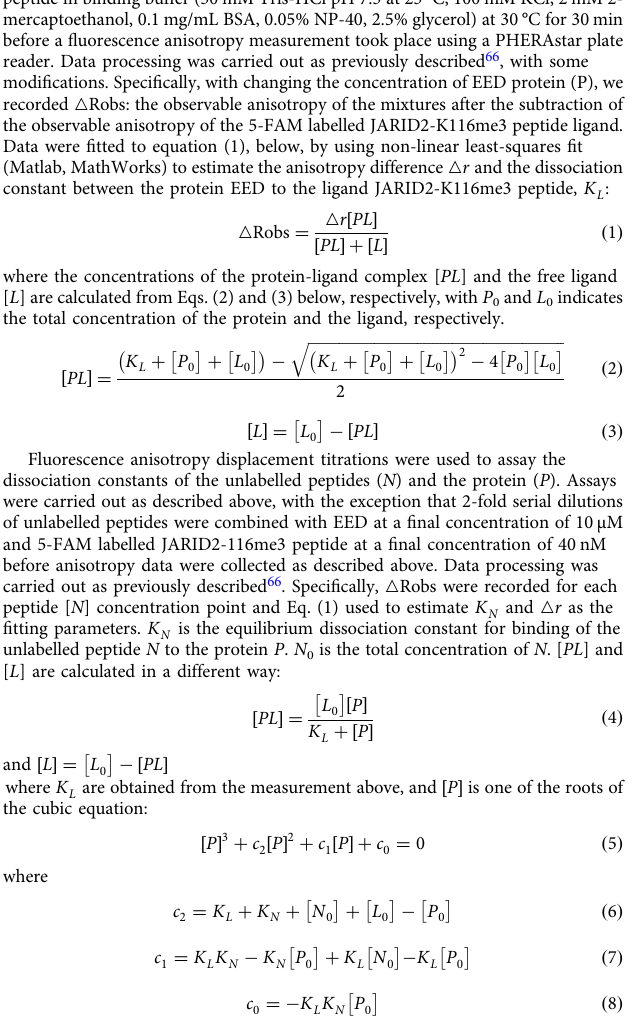
Electrophoretic mobility shift assay . Cy5-DNA or Cy5-H2A labelled nucleo- somes were diluted using binding buffer (50 mM Tris-HCl, pH7.5 at 25°C, 100 mM KCl, 2mM 2-mercaptoethanol, 0.05% v/v NP-40, 0.1 mg/mL BSA, 5% gly- cerol, with additional 5ng/µL Salmon Sperm DNA for measuring binding for Cy5- H2A labelled nucleosomes). In total, 2-fold serial dilutions of protein in binding buffer were combined with nucleosome probes, to a fi nal probe concentration of 5 nM. The reaction mixtures were incubated at 4 °C for 30 min and then subjected to non-denaturing gel electrophoresis at 6.6 V/cm over a 0.7% agarose gel buffered with 1× TBE at 4°C for 1.5h. Gels were imaged using Typhoon 5 Imager (GE Healthcare) to record signals from the Cy5 dye. The fractions of bound Cy5-DNA labelled nucleosomes were calculated based on the unbound nucleosomes band and the fractions of bound Cy5-H2A labelled nucleosomes were calculated based on the bound nucleosomes band, with the densitometry analysis carried out using ImageJ 56 . Data were fi tted with GraphPad Prism software using non-linear regression for speci fi c binding with Hill slope function. All experiments were performed in triplicate. For measuring the af fi nity of PALI1 PIR to DNA, the DNA probe was incubated for 2min at 95°C in 10 mM Tris-HCl pH 7.5 (at 25 °C) and was immediately snap- cooled on ice for 2 min. Next, DNA was allowed to fold at 37°C for 30 min in binding buffer (50 mM Tris-HCl pH 7.5 at 25°C, 100mM KCl, 2mM 2- the fl uorescently labelled DNA probe to a fi nal DNA probe concentration of 5nM. The mixtures were equilibrated at 30°C for 30 min and then subjected to non- denaturing gel electrophoresis at 6.6 V/cm over a 0.7% agarose gel buffered with 1× TBE at 4°C for 1.5h. Gels were imaged using Typhoon 5 Imager (GE Healthcare) to record signals from the fl uorescein dye. The fractions of DNA bound were calculated based on the unbound DNA bands, with the densitometry analysis carried out using ImageJ 56 . Data were fi tted with GraphPad Prism software using non-linear regression for speci fi c binding with Hill slope function. All experiments were performed in